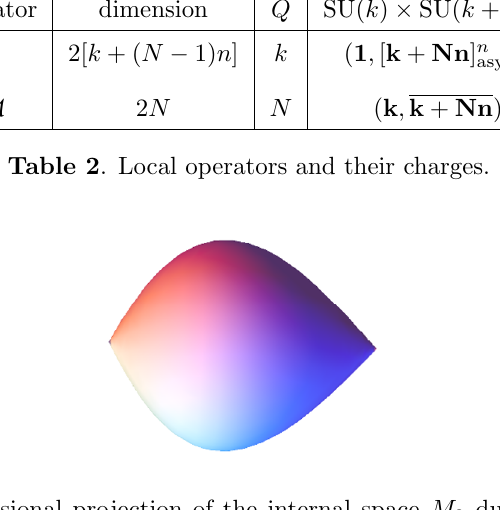
3 dual to the uniformly rising